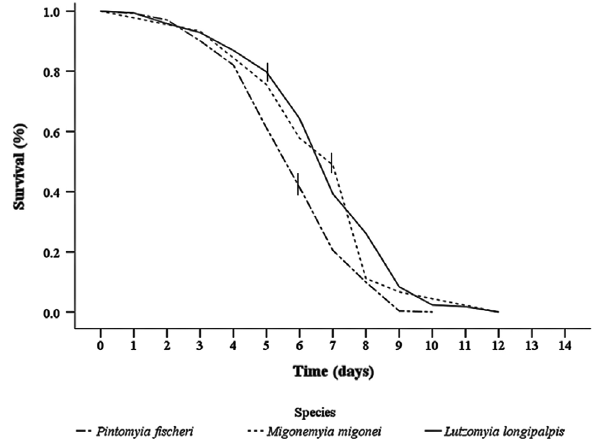
Figure 2. Survival curves of Migonemyia migonei , Pintomyia fischeri , and Lutzomyia longipalpis under laboratory conditions; the vertical line in the curve of each species indicates the median day of